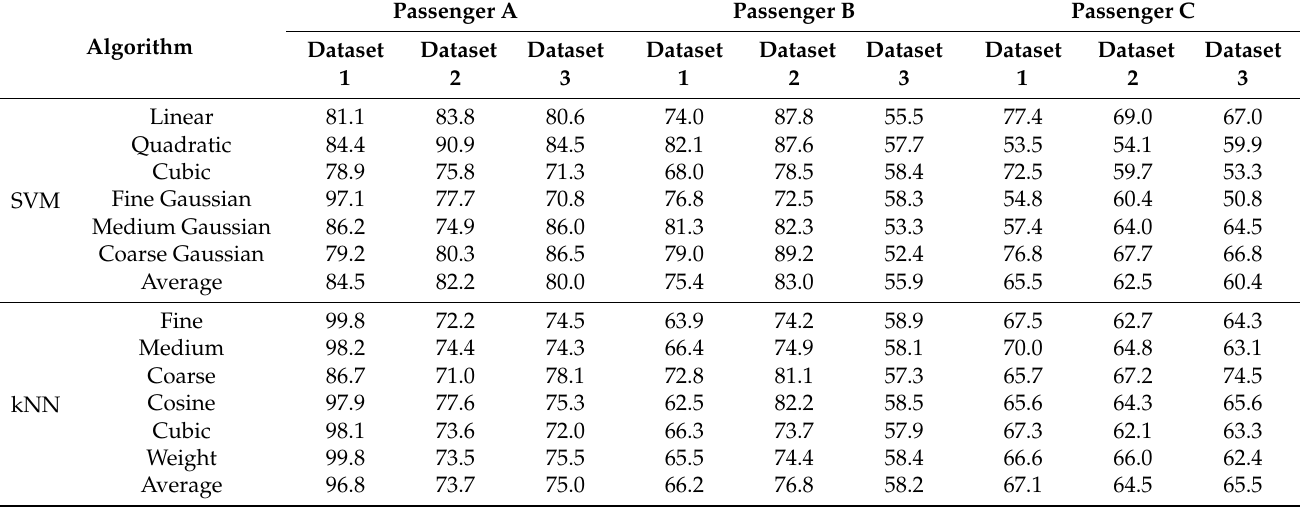
Table 5. Test accuracy of all